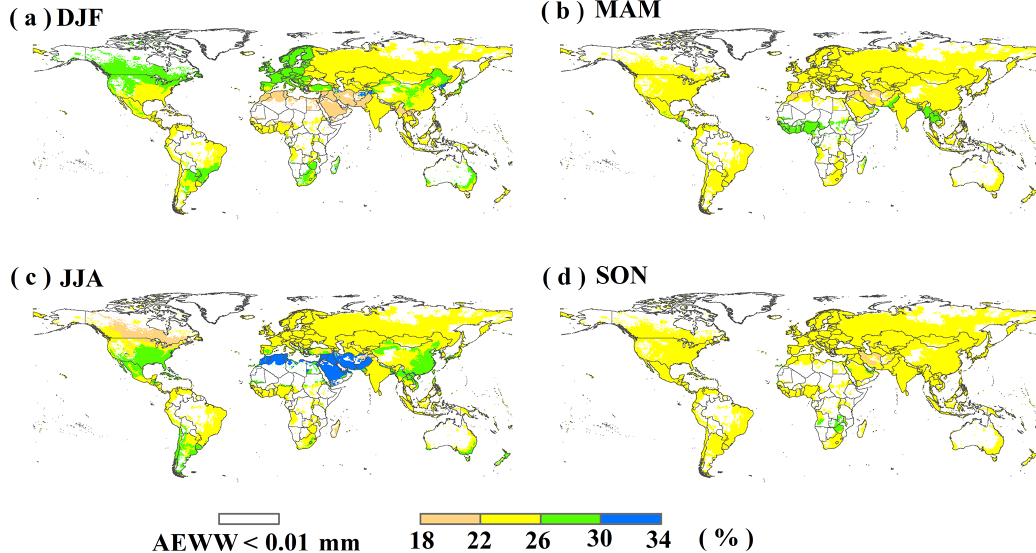
Figure 6. Relative seasonal distribution of global electricity generation water withdrawal over the period 1971–2010: December to Febru- ary (DJF), March to May (MAM), June to August (JJA), and September to November (SON), and grids with annual electricity water withdrawal (AEWW) are not taken into consideration.